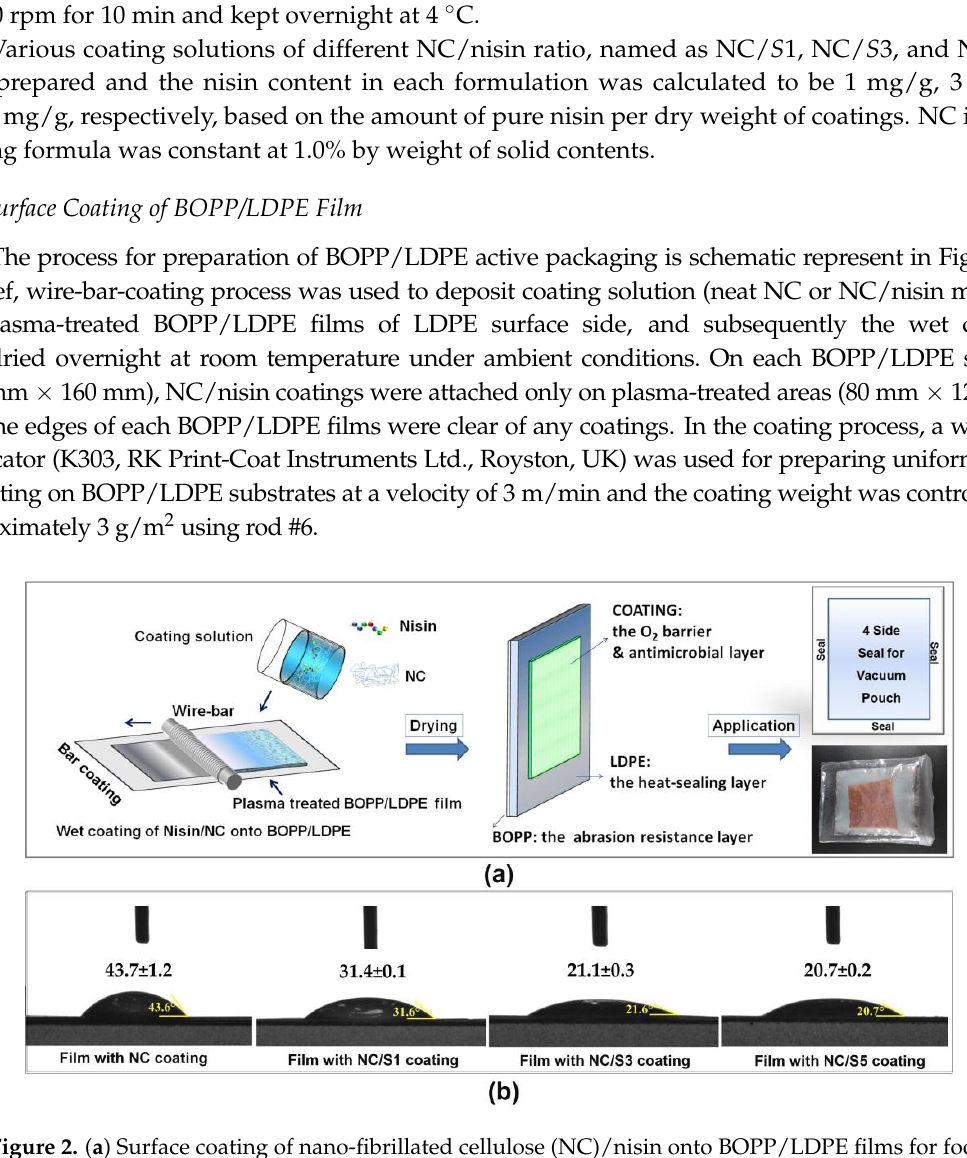
Figure 2. ( a ) Surface coating of nano-fibrillated cellulose (NC)/nisin onto BOPP/LDPE films for food packaging application; ( b ) SWCA of the coated film at different nisin